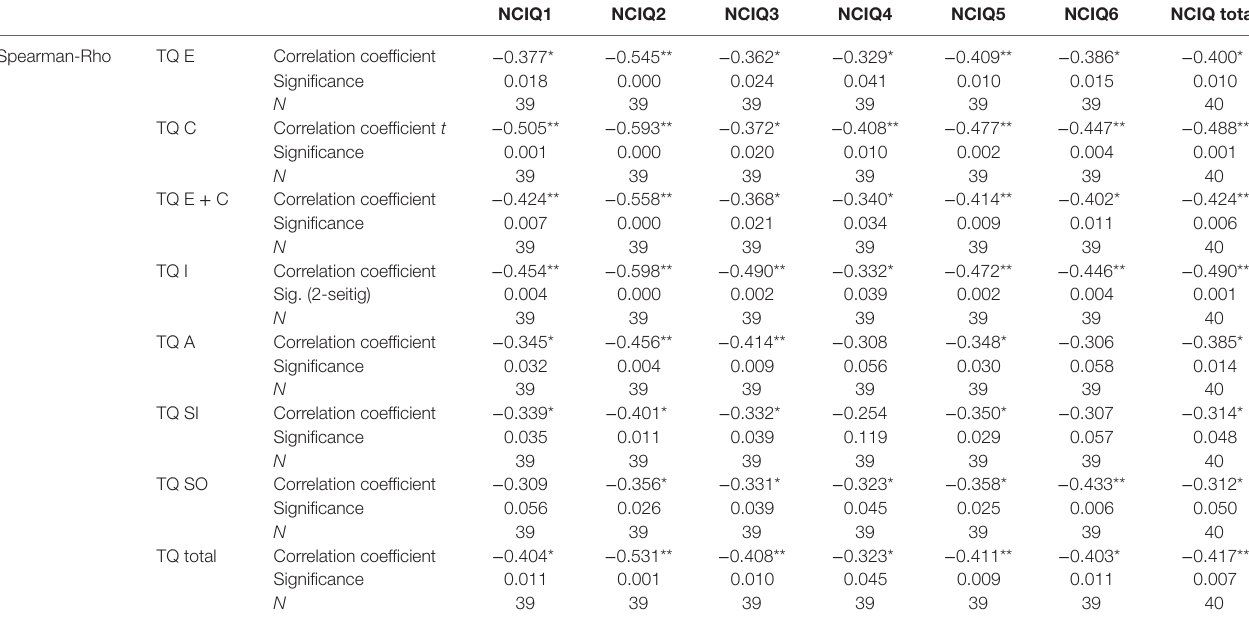
TaBle 6 | correlation between tinnitus and health-related quality of life 12 months after cochlear